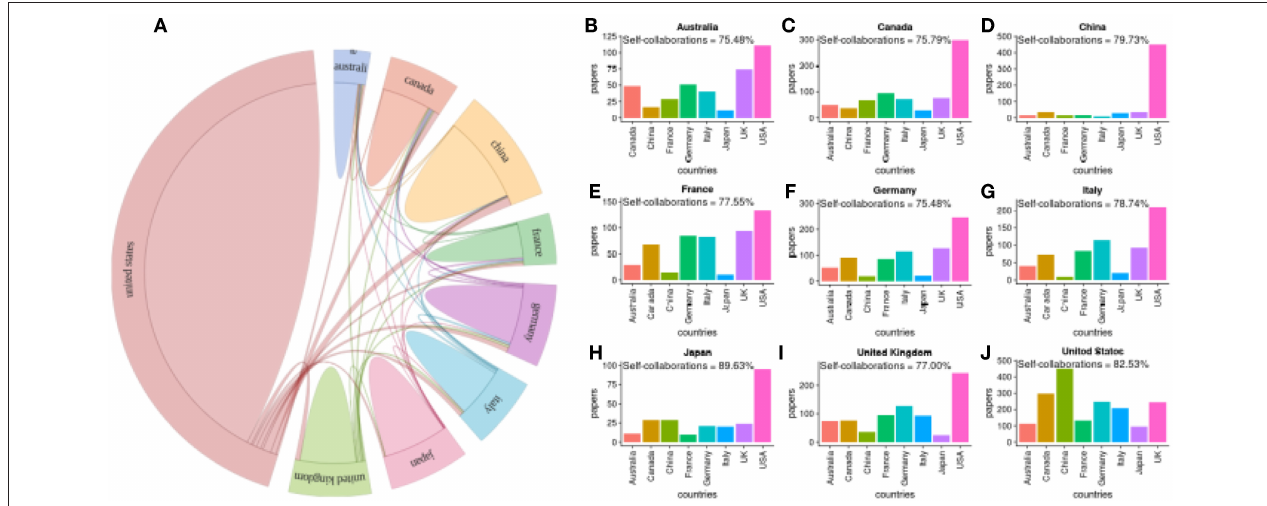
FIGURE 5 | (A) Summary of worldwide collaborations between countries for publications about prostate cancer research in genetics. (B–J) Pairwise collaborations between the top nine countries. Self-collaborations give the percentage of publications with all authors from the same country.